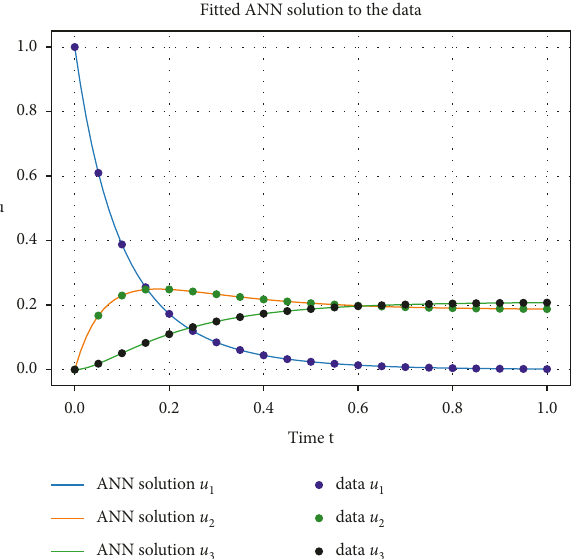
Figure 5: Neural network solution and the measured data for Example 4.